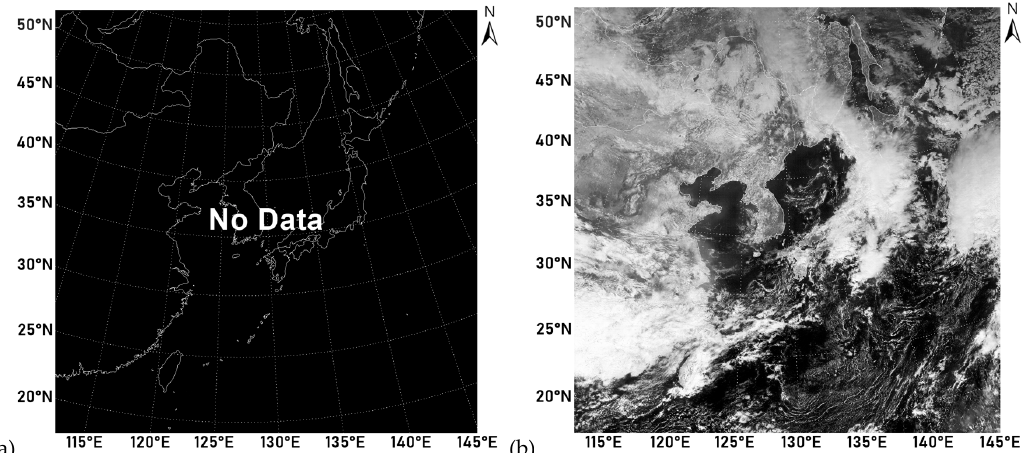
Figure 8. (a) No VIS observation and (b) AI-generated nighttime VIS reflectance image with 80,000 iterations on October 22, 2018 17:00 UTC (October 23, 02:00 KST, nighttime). At this time, there is no real VIS reflectance.